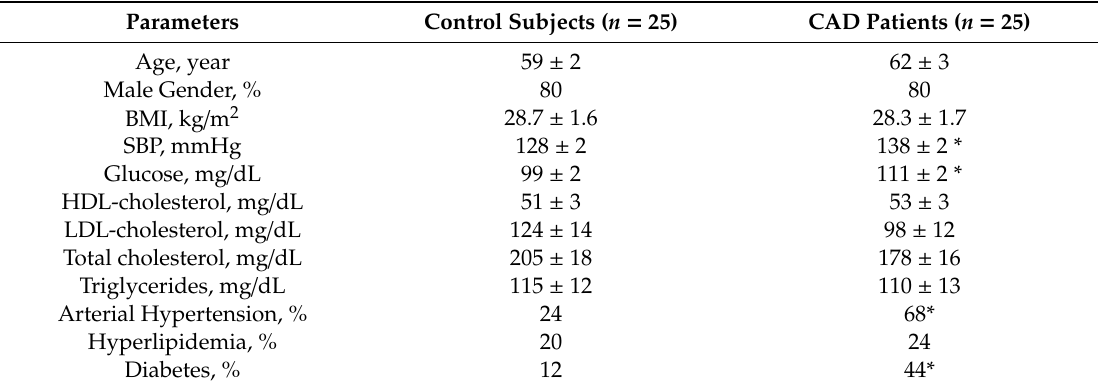
Table 2. Demographical and clinical characteristics of the cohort 2 .